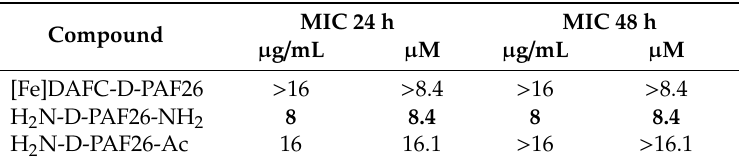
Table 3. MIC of A. fumigatus incubated for 24 h and 48 h with antifungal conjugates at 37 ◦ C in 0.1 × potato dextrose broth (0.1 × PDB ), important numbers are highlighted in bold (Values from three biological replicates).